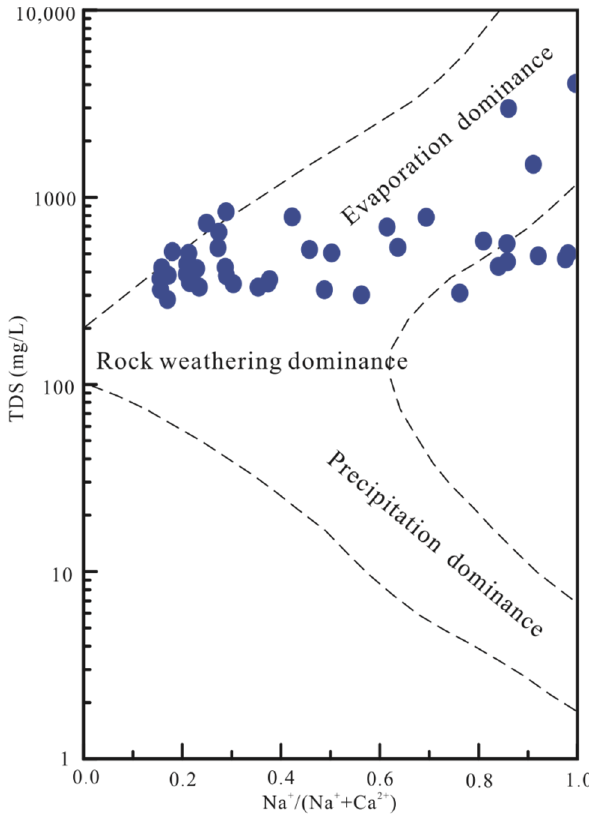
Figure 4. Gibbs diagrams for the groundwater in the study area.